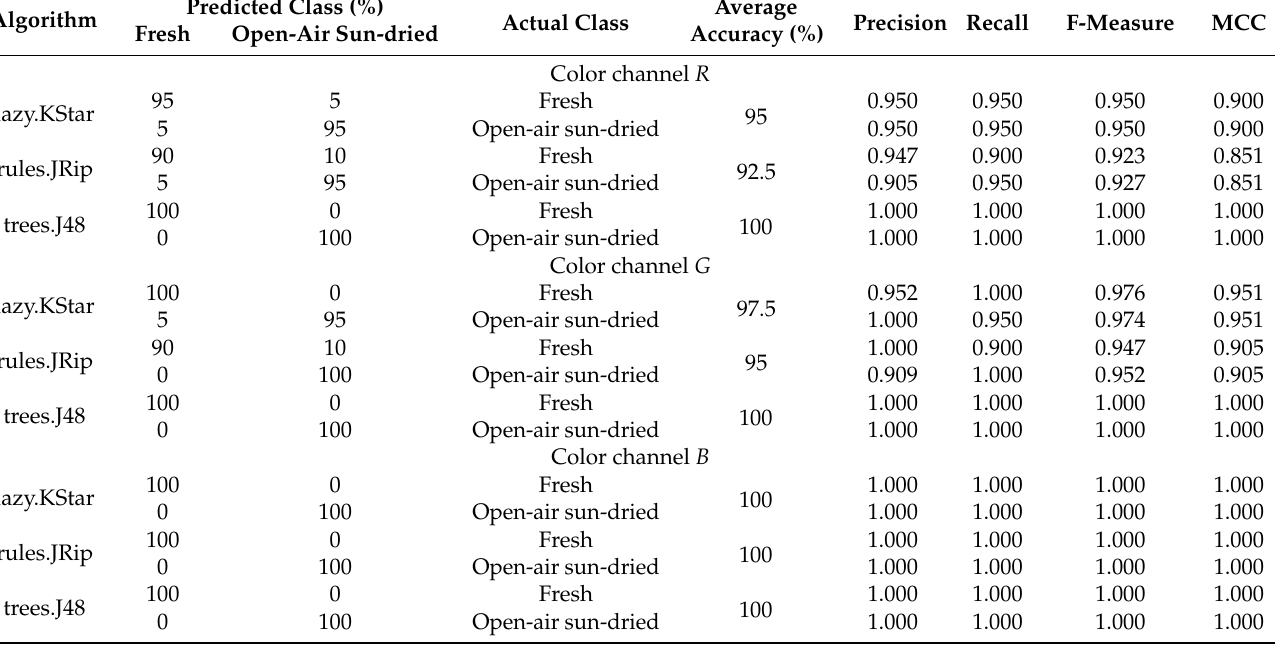
Table 4. The distinguishing of fresh and open-air sun-dried mint leaves imaged on the ventral side based on models including selected textures from color channels R , G , and B belonging to color space RGB.